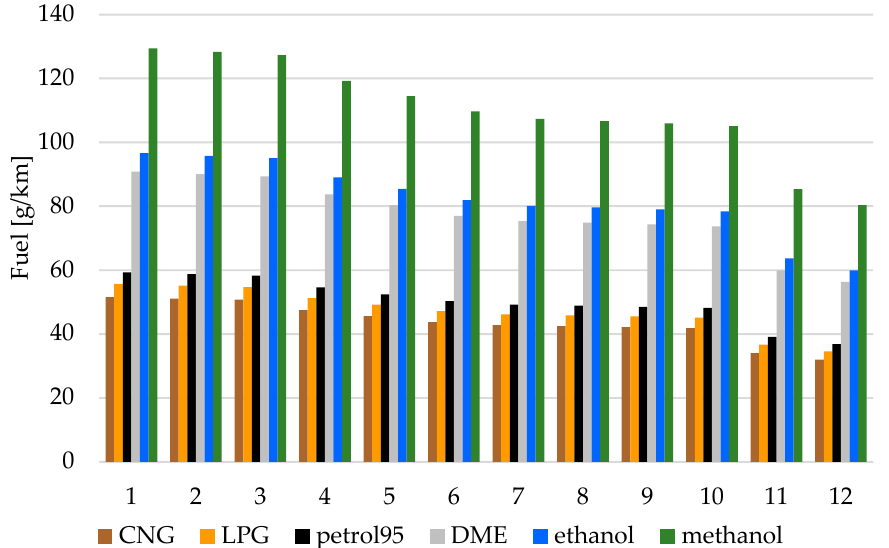
Figure 12. A summary of the mass consumption of the tested fuels per one kilometer driven: 1— Random cycle high (×95); 2—NEDC; 3—US SC03; 4—CADC wo mot; 5—Random Cycle Low (×05); 6—WLTC 3b random; 7—FTP-75; 8—CADC; 9—US 06; 10—CADC shortened; 11—MAC TP cycle; 12—US highway.